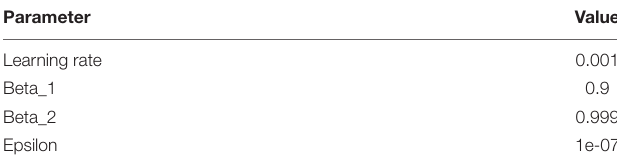
TABLE 2 | ADAM optimization function